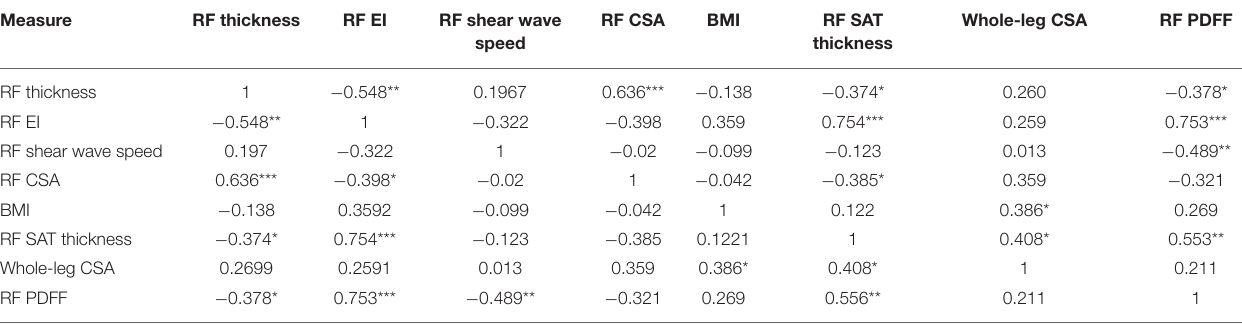
TABLE 3 | Bivariate associations between myosteatosis, including CT scans, and adiposity measures among older adults undergoing treatment for lung cancer ( n = 10). Measure RF RF EI RF shear RF CSA BMI SAT thickness wave speed